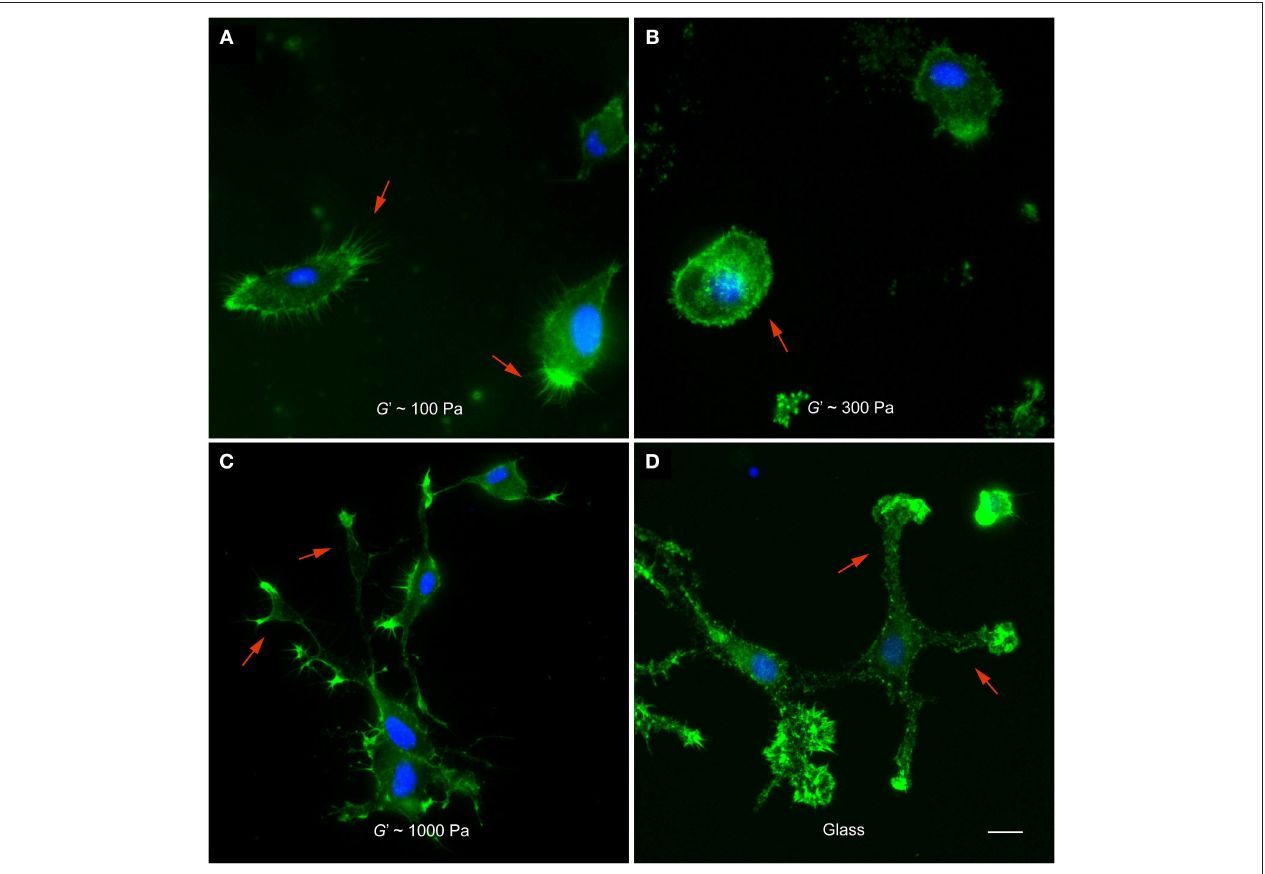
FIGURE 2 | Microglia morphology depends on substrate stiffness. (A–D) Representative fluorescence images of microglial cells on substrates of different stiffness. F-actin appears in green, nuclei in blue. (A) On substrates of G ′ ∼ 100 Pa, microglial cells showed many filopodia-like processes (red arrows). (B) On stiffer substrates ( G ′ ∼ 300 Pa), they showed amoeboid morphologies (red arrow) with significantly fewer processes ( p < 0 . 05 , Mann-Whitney U -test). (C,D) On 1000 Pa substrates and on glass, microglial cells had complex morphologies with lamellipodia-like structures at the tips of long processes (red arrows). Scale bar: 10 µ